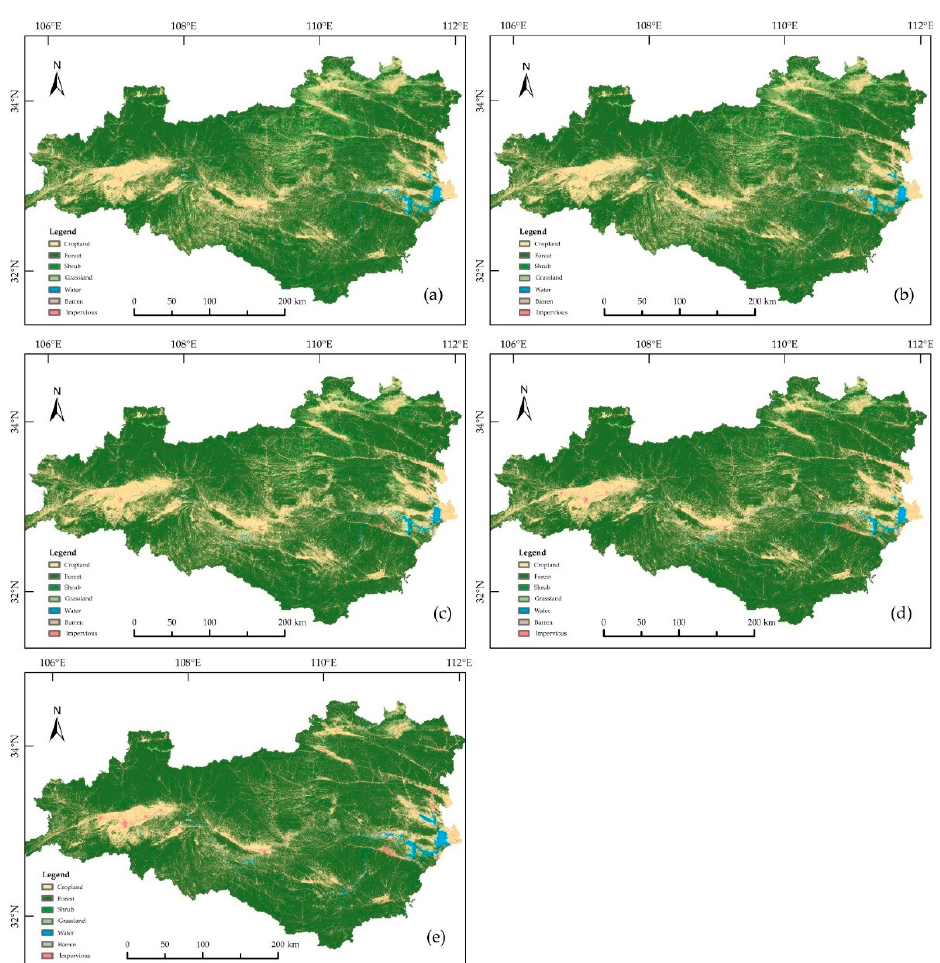
Figure 4. Map of land use change in water source area: ( a ~ e ) are land use and land cover charts in 1985, 1990, 2000, 2010 and 2020, respectively.